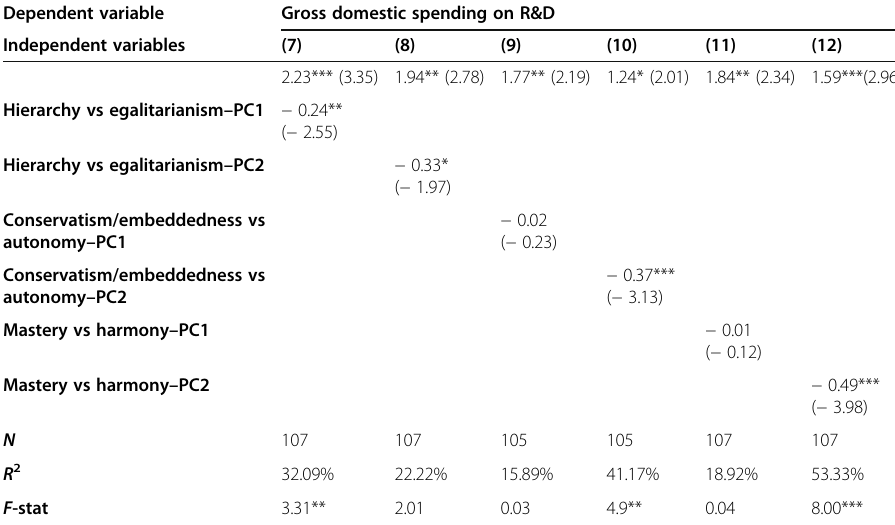
Table 11 The effect of culture on gross domestic spending on